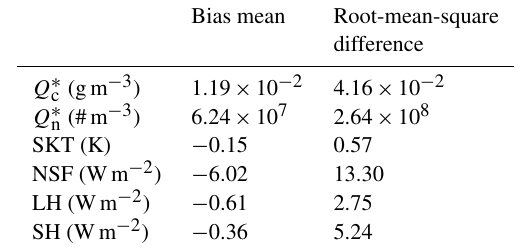
Table 7. Hourly bias mean and root-mean-square difference of cloud liquid water ( Q c ), cloud droplet number ( Q n ), surface skin temperature (SKT), net shortwave flux (NSF), latent heat flux (LH) and sensible heat flux (SH) between internally mixed (I_ARon_CRmod) and source-oriented (S_ARon_CRmod) exper- iments (internally mixed – source-oriented) during 16 to 18 January